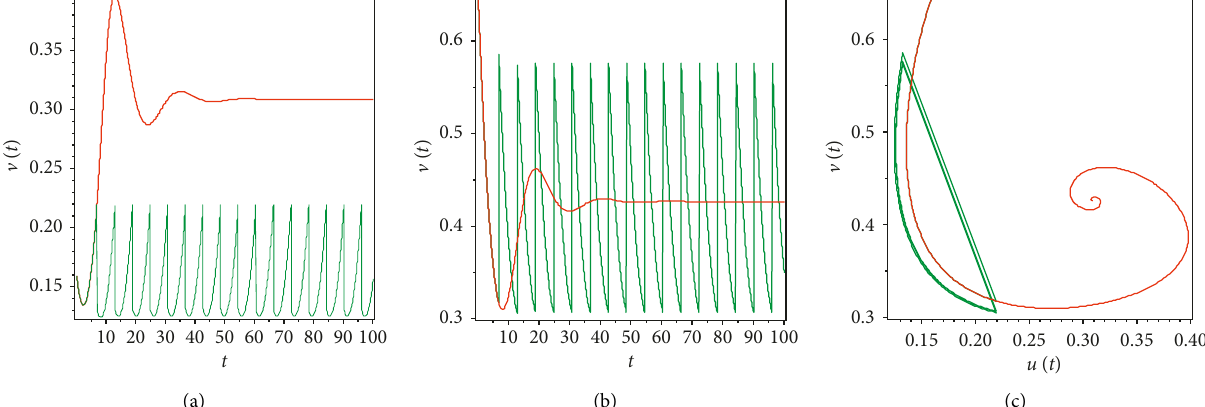
Figure 4: State pulse feedback control strategy of system (5): s � 2, A � 0 . 5, δ � 1, d � 0 . 25, k